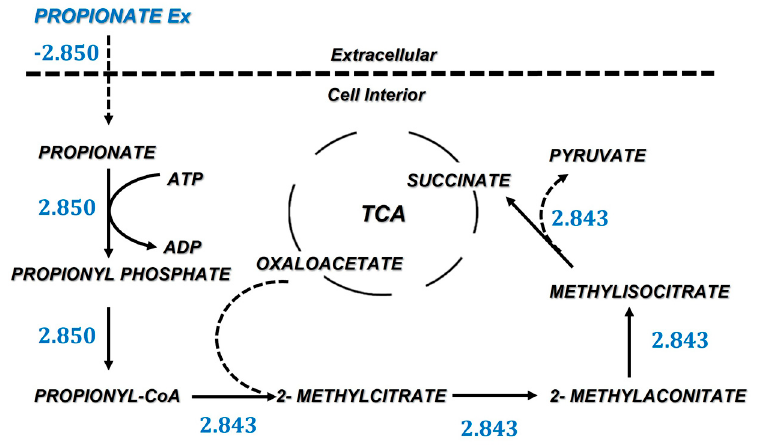
Figure 4. Metabolic pathway and fluxes for the incorporation of propionate to central carbon me- tabolism.